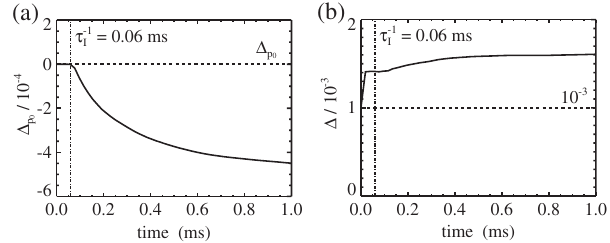
FIG. 11. Multistream instability and the effect of a broadband resonator impedance. Part (a) shows as a solid curve the simulated energy loss and (b) the momentum spread evolution. In both figures the dotted dashed, vertical line presents the microwave instability growth rate.